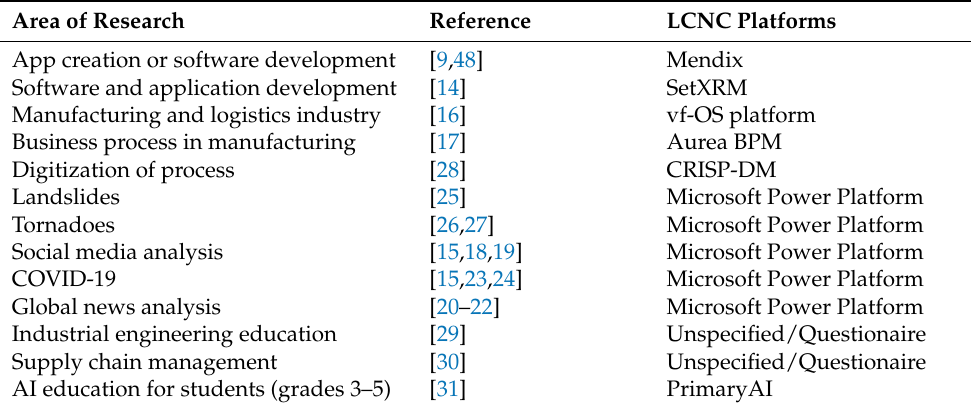
Table 4. Different area of research supported by existing LCNC